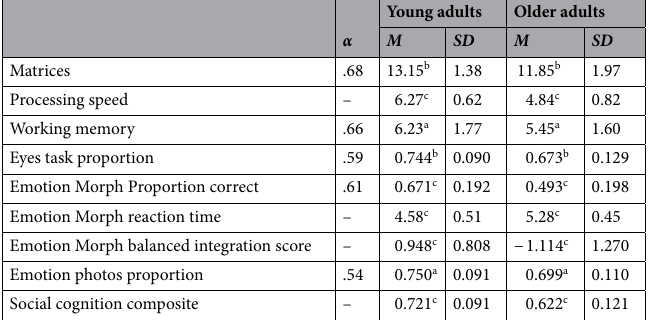
Table 1. Descriptive statistics and reliability. Cronbach’s alpha measures the reliability of tasks. For each task, we compared young and older adults’ performance using t -tests, with young adults always having better performance. Superscripts indicate the level of significant difference: a p < .05, b p < .01, c p < .001.